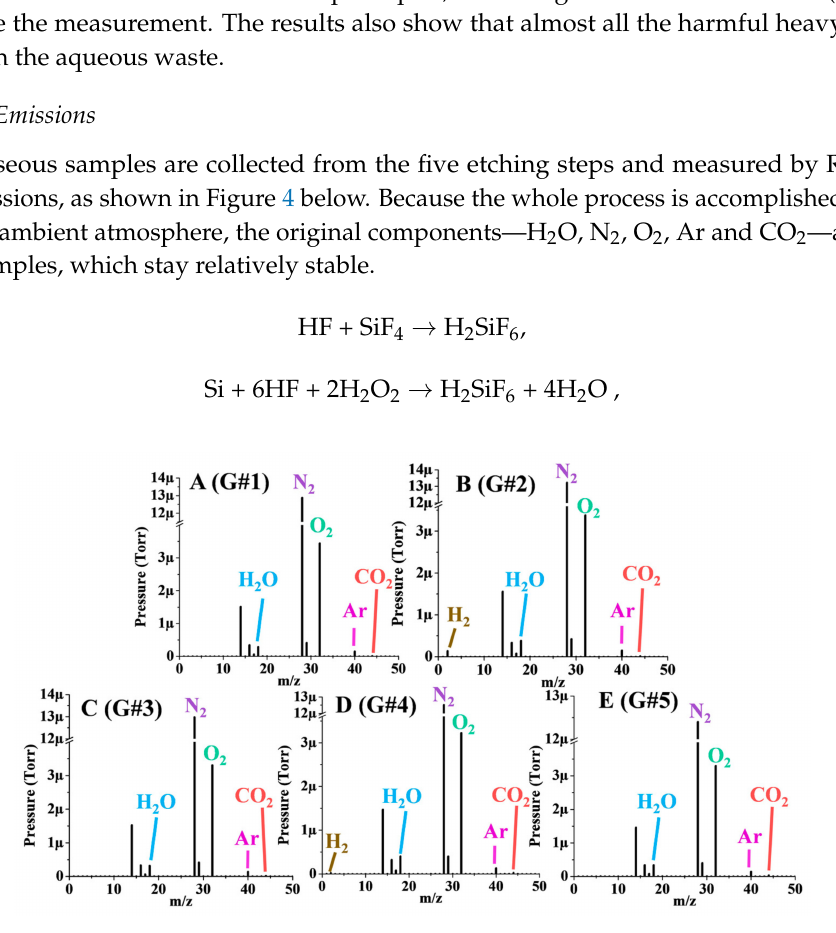
Figure 4. RGA-measured gaseous emissions from the five etching